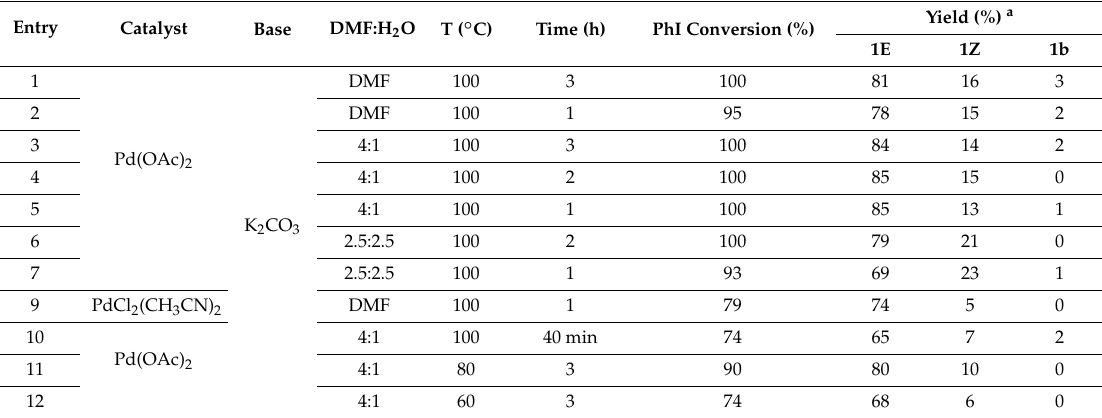
Table 1. Results of the Heck arylation of eugenol with iodobenzene.